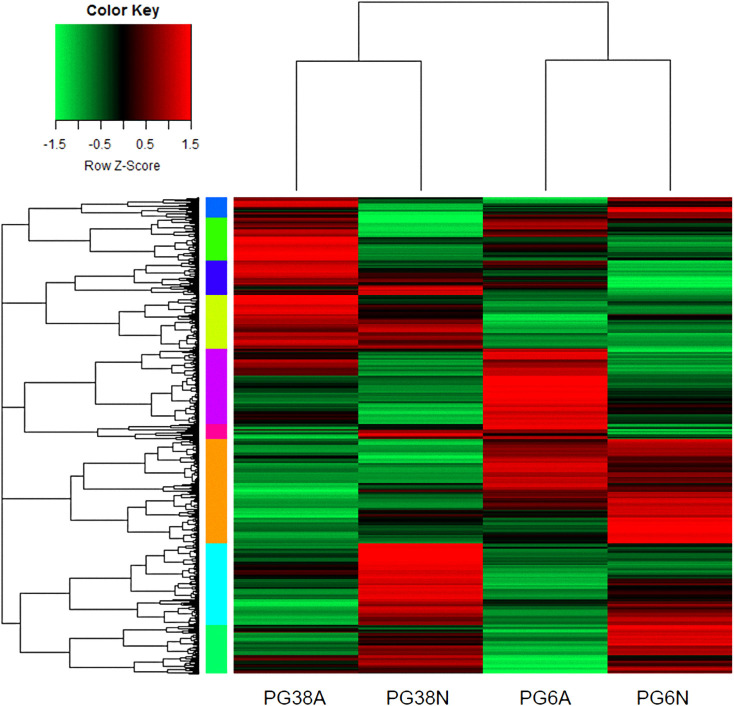
Overview of gene expression.Gene expression levels were displayed from green (downregulated) to red (upregulated). Colored bars on the left of the heatmap mark distinct major branches in the clustering tree grouping genes with similar expression pattern. Each row corresponded to a single gene and each column to the mean of the three biological repetitions of one experimental condition. The heatmap was generated with scripts based on heatmap.2 function as available in the “gplots” R package. A: acidic pH and N: neutral pH.